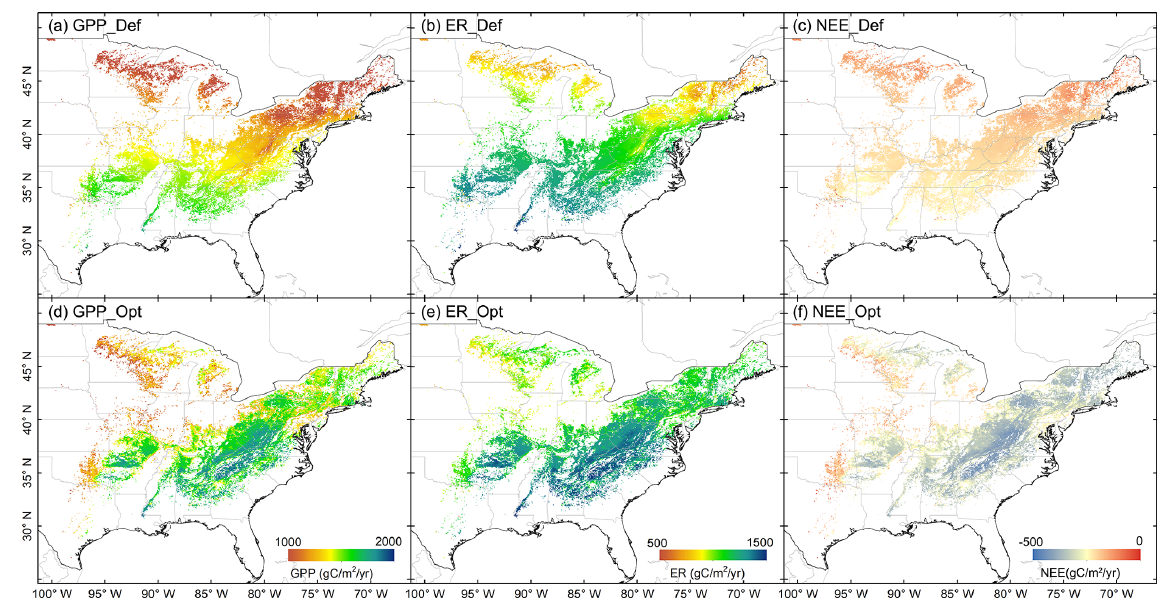
Figure 11. Regional patterns of mean annual carbon fluxes (GPP, NEE, and ER) for the years 2000–2019. Panels (a) – (c) show spatial distribution of each flux from the model with default parameters and (d) – (f) show distributions with optimized scheme.